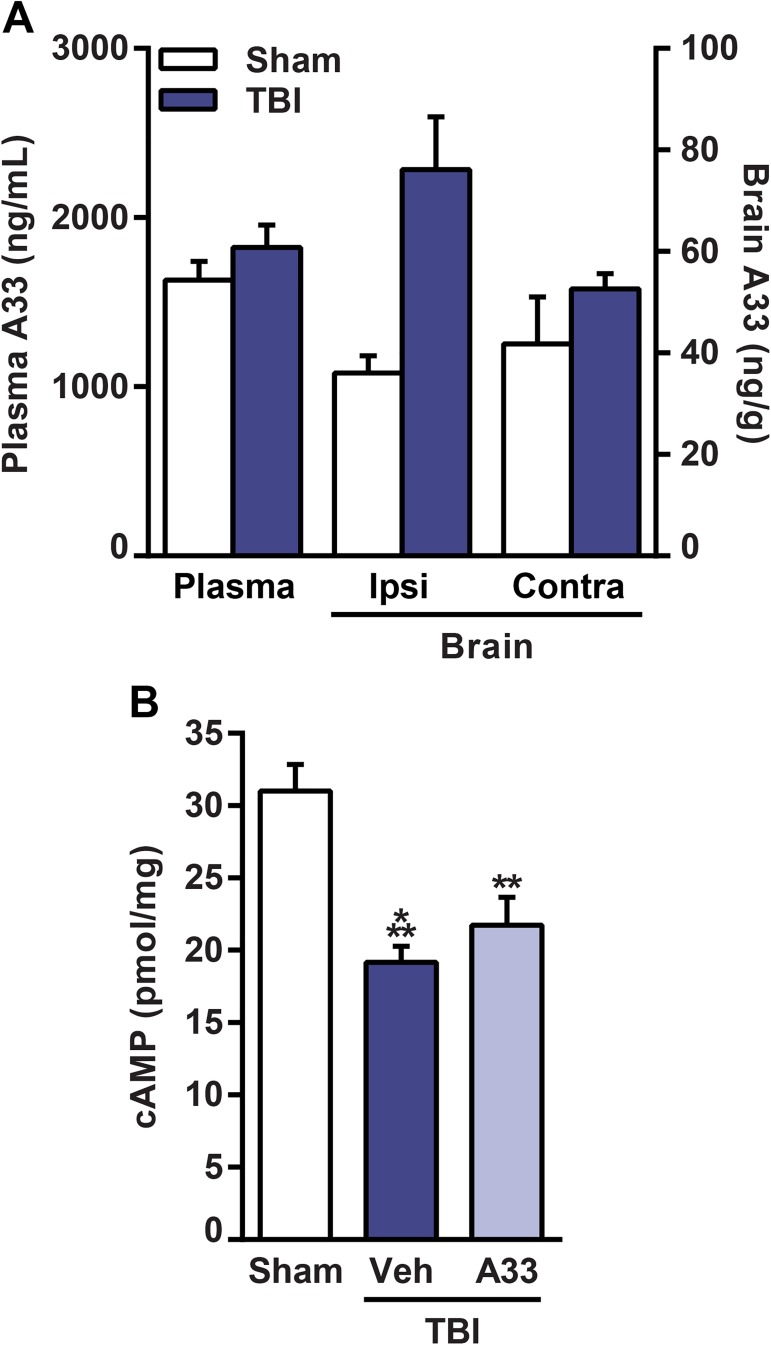
Distribution of A33 to the brain and plasma and effects on cAMP levels.(A) A33 levels were measured in the plasma and brain at 1 hr after A33 administration (0.3 mg/kg, i.p.). A33 levels were significantly higher in the brains of TBI animals as compared to sham animals (main effect of surgery: F(1,8) = 11.986, p = 0.009 for brain A33 levels). Mean ± SEM, n = 3/group, two-way ANOVA with post-hoc Student-Newman-Keuls (brain), Student’s unpaired t-test (plasma). (B) Total cAMP levels were significantly decreased in the ipsilateral parietal cortex of vehicle- and A33-treated TBI animals as compared to sham animals. A33 treatment did not increase total cAMP in the cortex at 6 hrs post-injury as compared to vehicle-treated TBI animals. Mean ± SEM, n = 9-12/group, **p<0.01, ***p<0.001 vs. Sham, one-way ANOVA with post-hoc Student-Newman-Keuls.